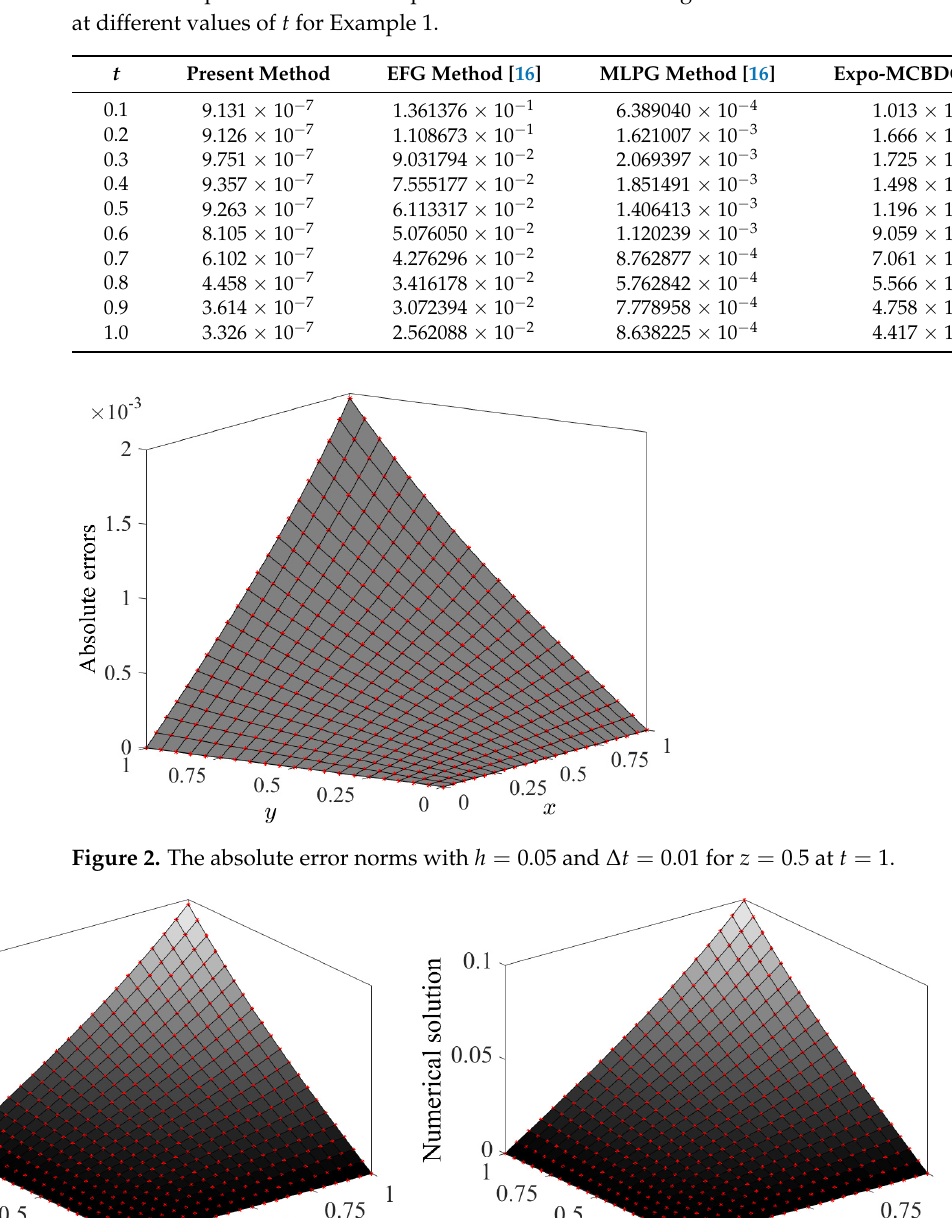
Figure 3. The analytical ( a ) and numerical ( b ) solutions with h = 0.05 and ∆ t = 0.01 for z = 0.5 at t = 1 .